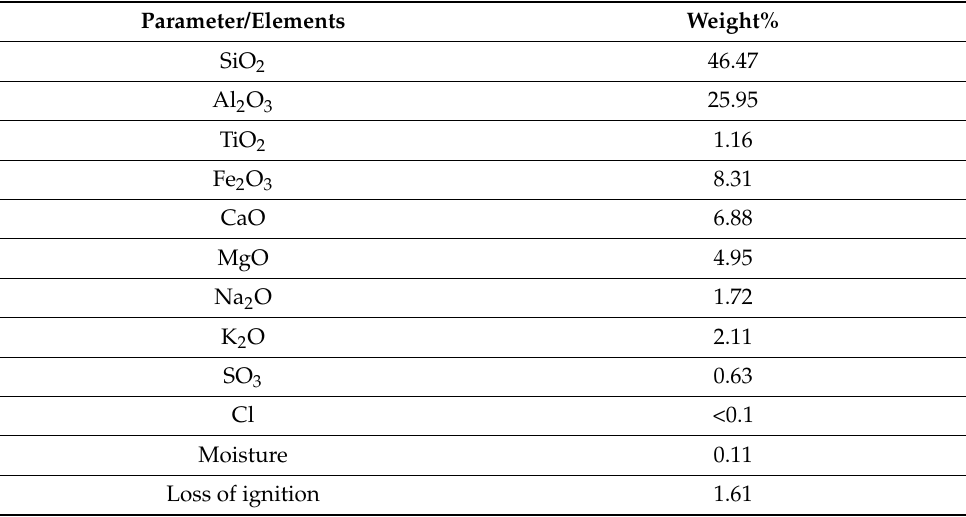
Table 1. Fly ash components.